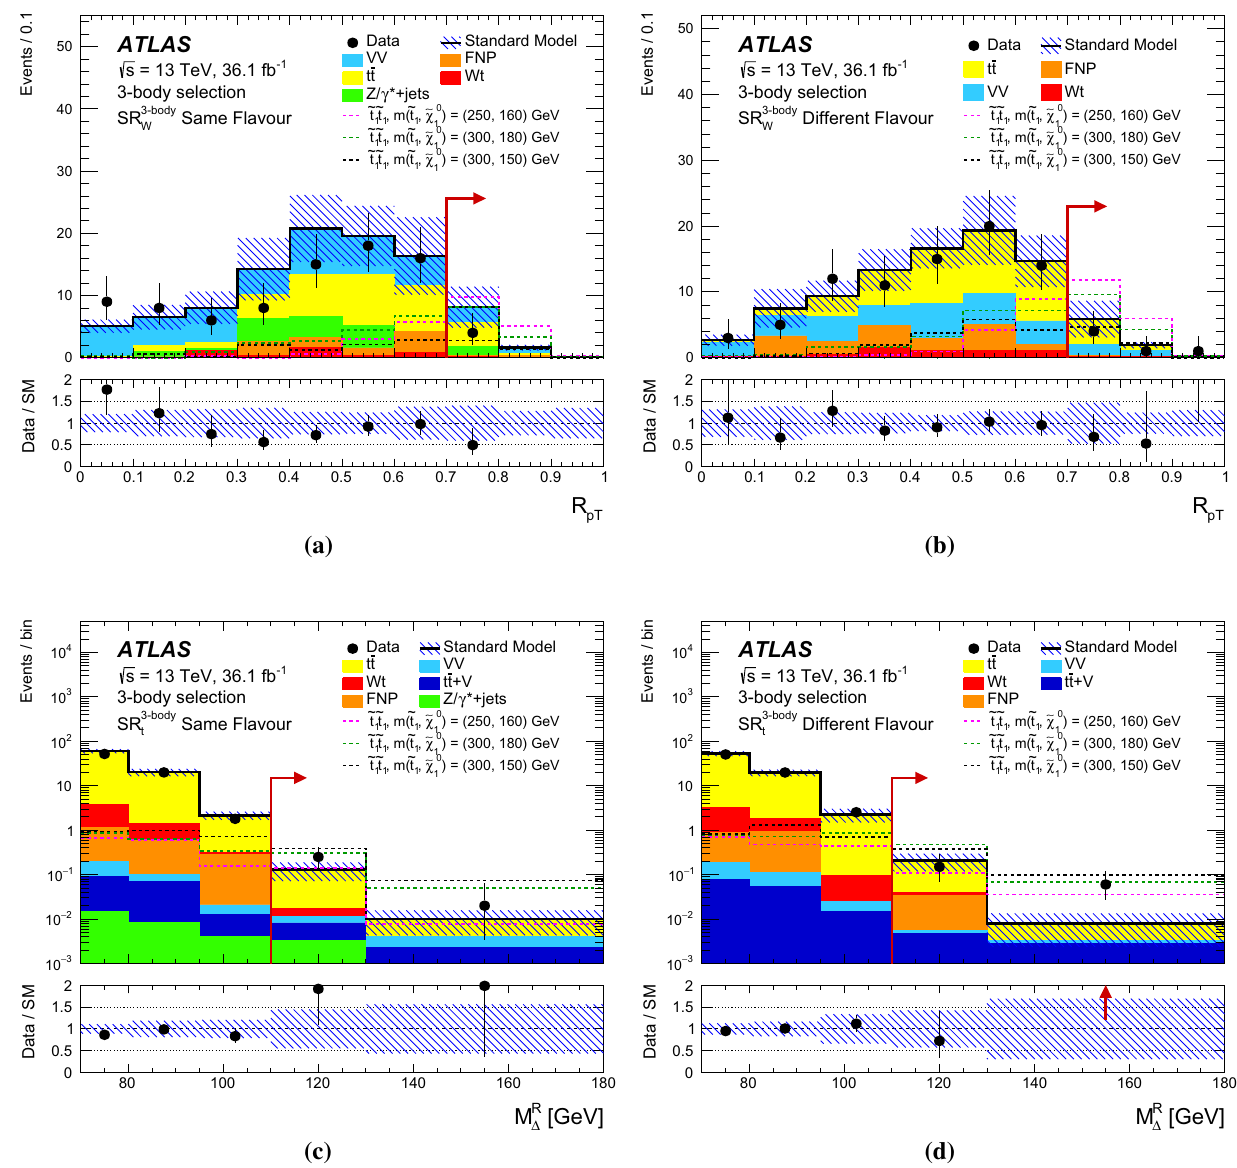
Fig. 7 Three-body selection distributions of R p togram stack; the hatched bands represent the total uncertainty in in a same-flavour T the background predictions after the fit to the data has been per- and b different-flavour events that satisfy all the SR 3-body selec- W formed. The counting uncertainty on data is also shown by the tion criteria except for the one on R p , and of M R (cid:10) in the c same- black error bars. The rightmost bin of each plot includes overflow T flavour and d different-flavour events that satisfy all the SR 3-body t events. Reference top squark pair production signal models are over- layed for comparison. Red arrows indicate the signal region selection selection criteria except for the one on M R (cid:10) after the background fit. The contributions from all SM backgrounds are shown as a his-